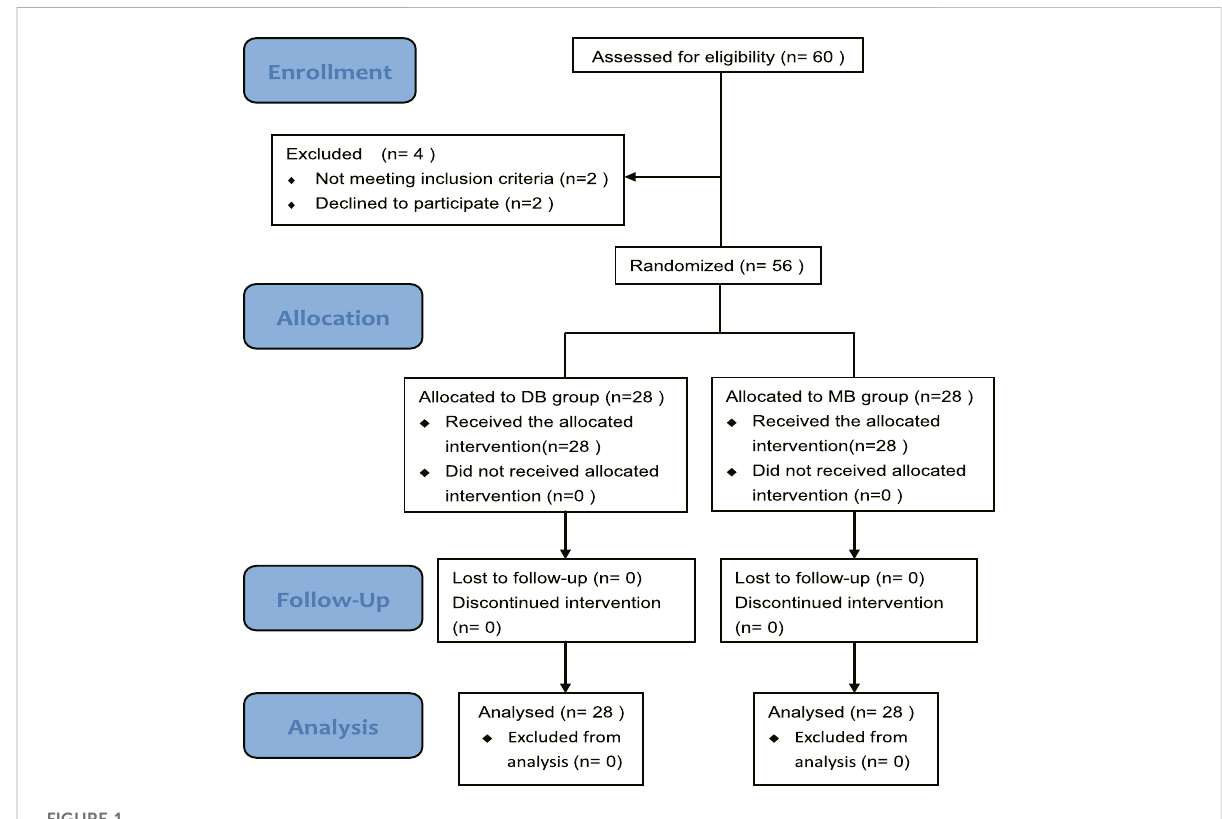
FIGURE 1 CONSORT fl ow diagram of the trial. Abbreviation: DB, dexmedetomidine-butorphanol; MB,